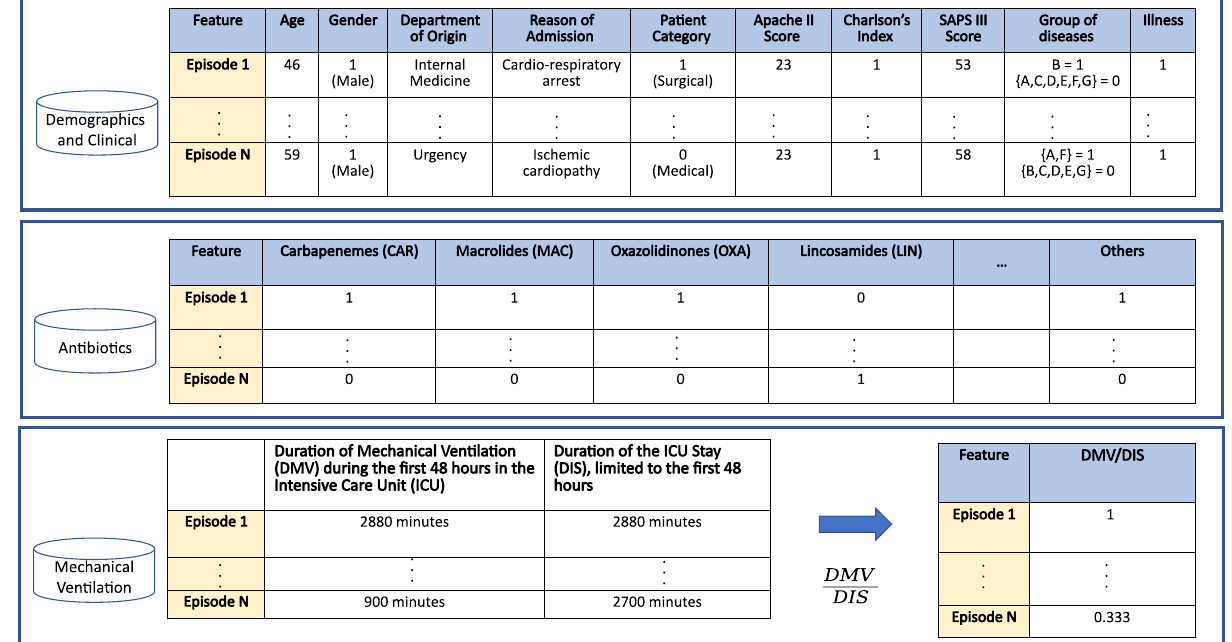
Figure 3. Schematic dataset description.